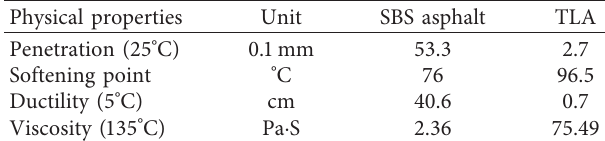
Table 1: SBS-modified asphalt and TLA performance test results. Physical